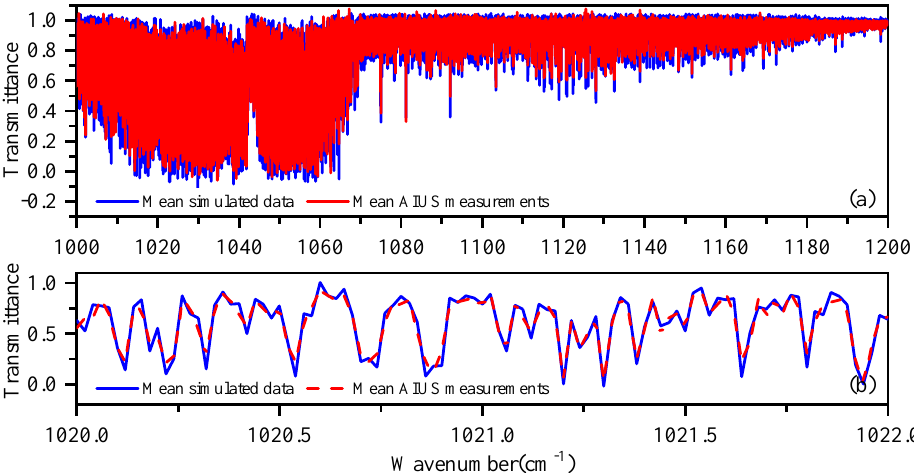
Figure A1. Mean transmittance of AIUS measurements and simulations in 1000–1200 cm − 1 at 40 km. Figure A2 shows the transmittance differences between AIUS measurements and simulations in 1000–1200 cm − 1 at 15 km, 20 km, 40 km, and 60 km, respectively. Figure A2a indicates that the transmittance differences were mostly within ± 0.1 in 1000–1065cm − 1 and ± 0.05 in 1065–1200 cm − 1 at 60 km. Figure A2b shows that the transmittance differences were within ± 0.2 in 1000–1065 cm − 1 and ± 0.1 in 1065–1200 cm − 1 at 40 km. Figure A2c,d show that the transmittance differences were within ± 0.1 in 1000–1060 cm − 1 and ± 0.2 in 1060–1200 cm − 1 at 40 km and 20 km. In 1000–1060 cm − 1 , the larger differences were found at 40 km where the absorption was strong. In 1080–1200 cm − 1 , the transmittance differences decreased with altitude